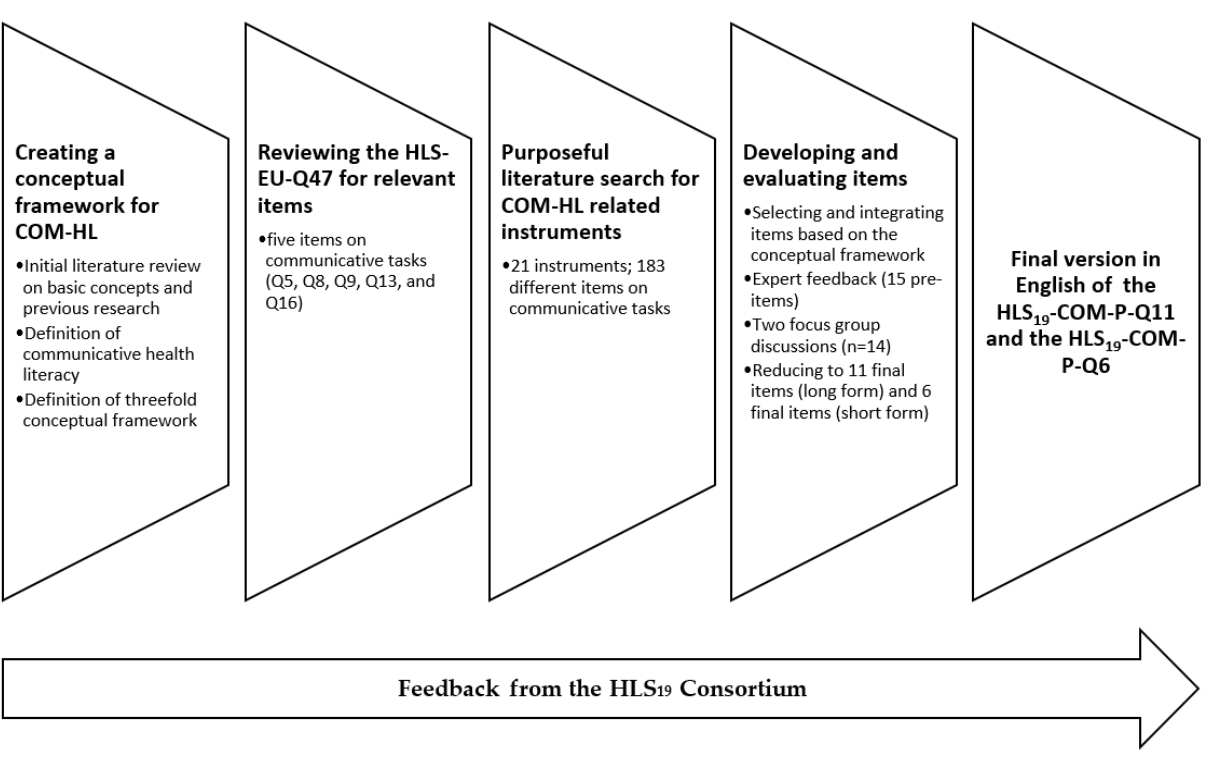
Figure 2. Steps in the development of the instrument to measure communicative health literacy. Table 1. Overview of items included in the instrument for measuring communicative health literacy. Items constituting the short version are in italics.